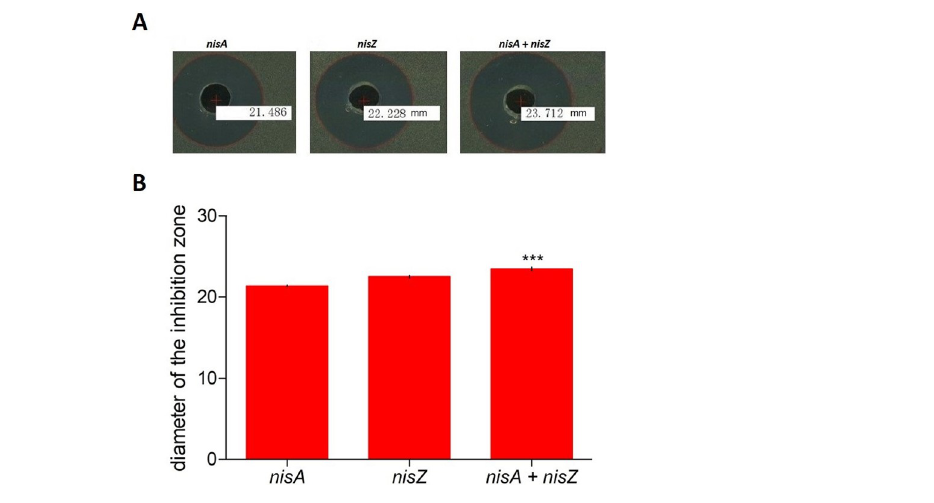
Fig 5. Antimicrobial activity of L . lactis subsp. lactis strains expressing nisA , nisZ and nisA + nisZ genes against M . luteus . The plates’ holes were filled with 150 ml of pasteurized supernatant from overnight cultures of L . lactis subsp. lactis strains. (A) Inhibition area; (B) inhibition diameter in millimeters. The bars represent means of three independent replicates ± standard error (P <